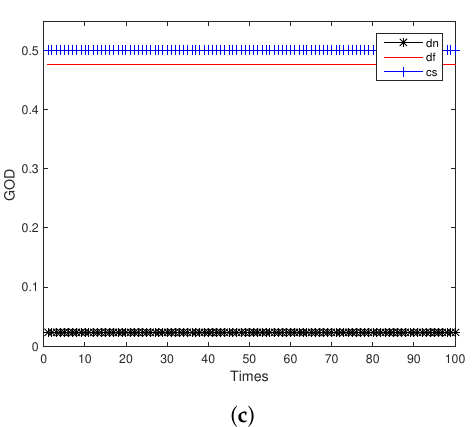
Figure 9. Observable degree comparison among different fusion methods for same index 3:( a ) LOD of Sx; ( b ) LOD of Vx; ( c )